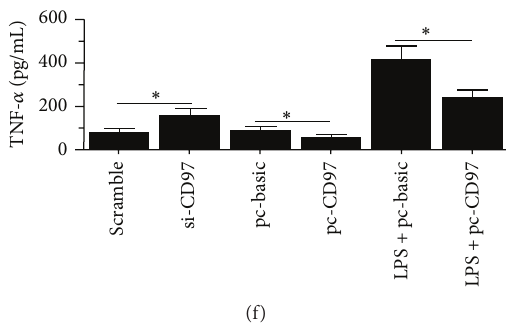
Figure 1: Effect of CD97 on LPS mediated TNF- 𝛼 secretion in macrophages. (a) CD97 protein levels increased when monocytes differentiated into macrophages in the presence of GM-CSF (100 ng/mL). (b) LPS (0 to 60 ng/mL) treatment for 24 h inhibited CD97 protein expression in a concentration dependent manner (A). LPS (60ng/mL) inhibited CD97 protein levels in a time gradient manner (0 to 12 h) (B). (c) Macrophages were treated with LPS (0 to 60 ng/mL) for 24 h. Cells were incubated with FITC-conjugated-anti-CD97 antibody. CD97 expression was analyzed by flow cytometry. (d) Macrophages were treated with LPS (0 to 60 ng/mL) for 24 h; total RNA was extracted and reverse transcription was performed. Finally, qRT-PCRs were performed to measure the expression of three CD97 isoforms. (e) CD97 expression/distribution in macrophages treated with or without LPS (40 ng/mL) for 24 hours by confocal microscopy. The red color represents CD97 staining. (f) siRNA of CD97 transfection upregulated TNF- 𝛼 secretion whereas ectopic expression of CD97 downregulated TNF- 𝛼 secretion. LPS (40ng/mL) induced TNF- 𝛼 secretion was blocked by CD97 ectopic expression ( 𝑝 < 0.05